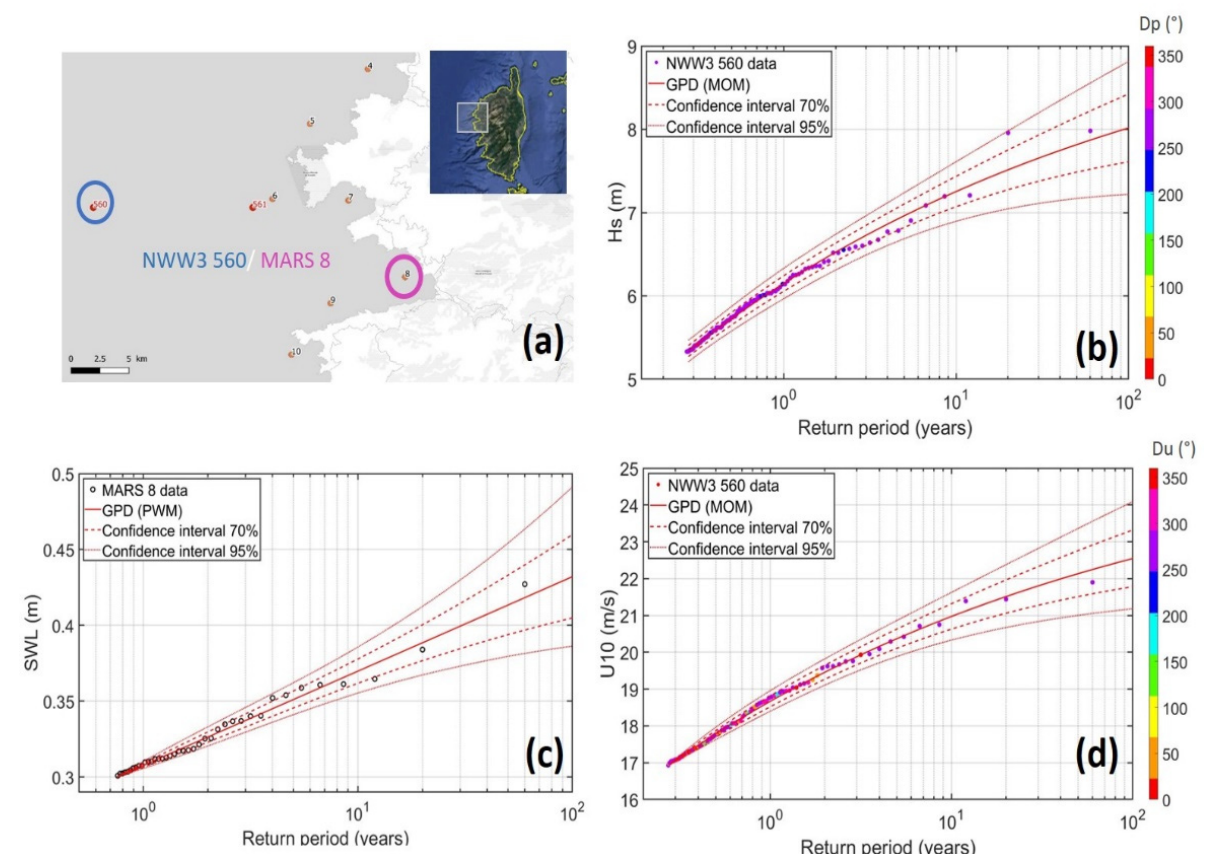
Figure 3. Example of the marginal distributions’ fitting. ( a ) Location of the points considered. NWW3 560 provides U (m/s) and Hs (m), MARS 8 provides SWL (m). Generalized Pareto Distribution (GPD) and associated 70% (red dashed lines) and 95% (red thin lines) CI for ( b ) Hs, ( c ) SWL, and ( d ) U. Color bars give the directions Dp and Du (°).